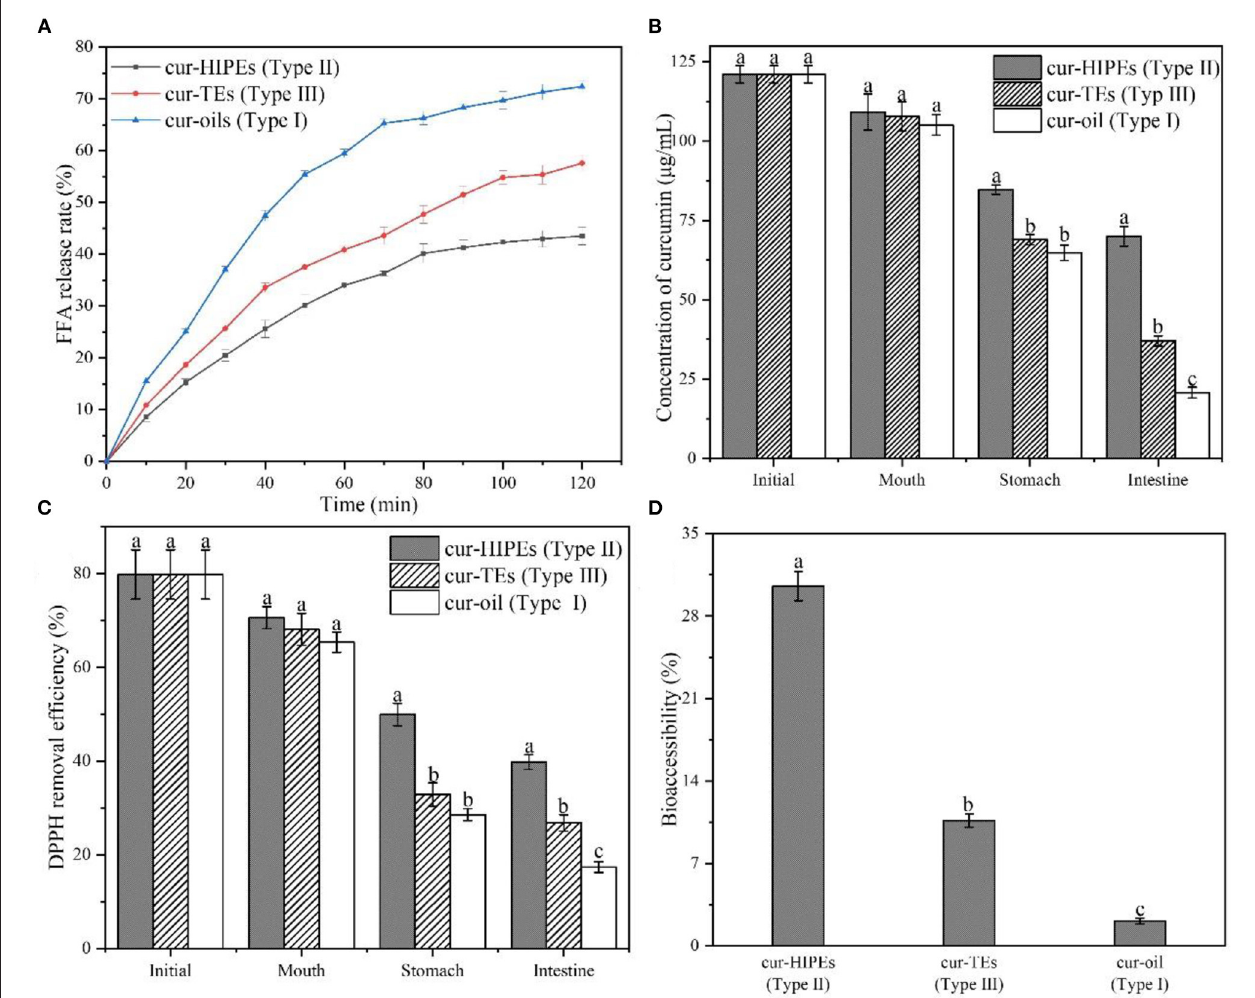
FIGURE 7 | FFA release rate (A) , concentration of curcumin (B) , 1,1-diphenyl-2-picrylhydrazyl (DPPH) removal efficiency (C) , and bioaccessibility of curcumin (D) during in vitro